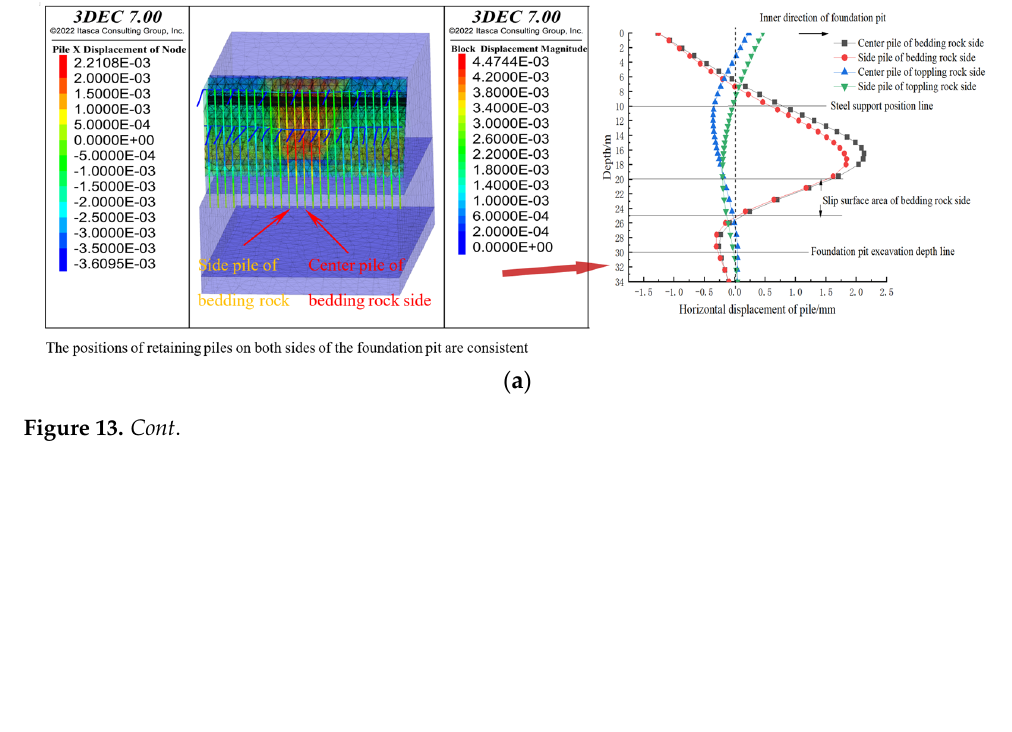
( c ) Figure 13. Analysis on the stress of pile-bracing support system. ( a ) displacement of retaining piles with a pile spacing of 2.0 times; ( b ) displacement of retaining piles with a pile spacing of 3.0 times; ( c ) displacement of retaining piles with a pile spacing of 4.0 times. As seen from Figure 13b,c, the displacement of the pile body generated by 3.0 times the pile spacing and the displacement produced by 4.0 times the pile spacing are each increased. The basic rules are that the maximum displacement of the pile body is increased by approximately 1 mm when the pile spacing is increased once by the pile diameter each time; the zero point of displacement also starts moving downward; if a pile spacing of 4.0 times is reached, the deformation of the middle and side piles occurs almost simultane- ously, indicating that the whole support system starts to fail. At this moment, the sliding force of the rock mass is born by the retaining pile within the range of slip. The retaining pile on the toppling rock side also faces the same conditions, and deformation on the mid- dle piles and side piles occurs nearly synchronously when the pile spacing reaches 4.0 times.